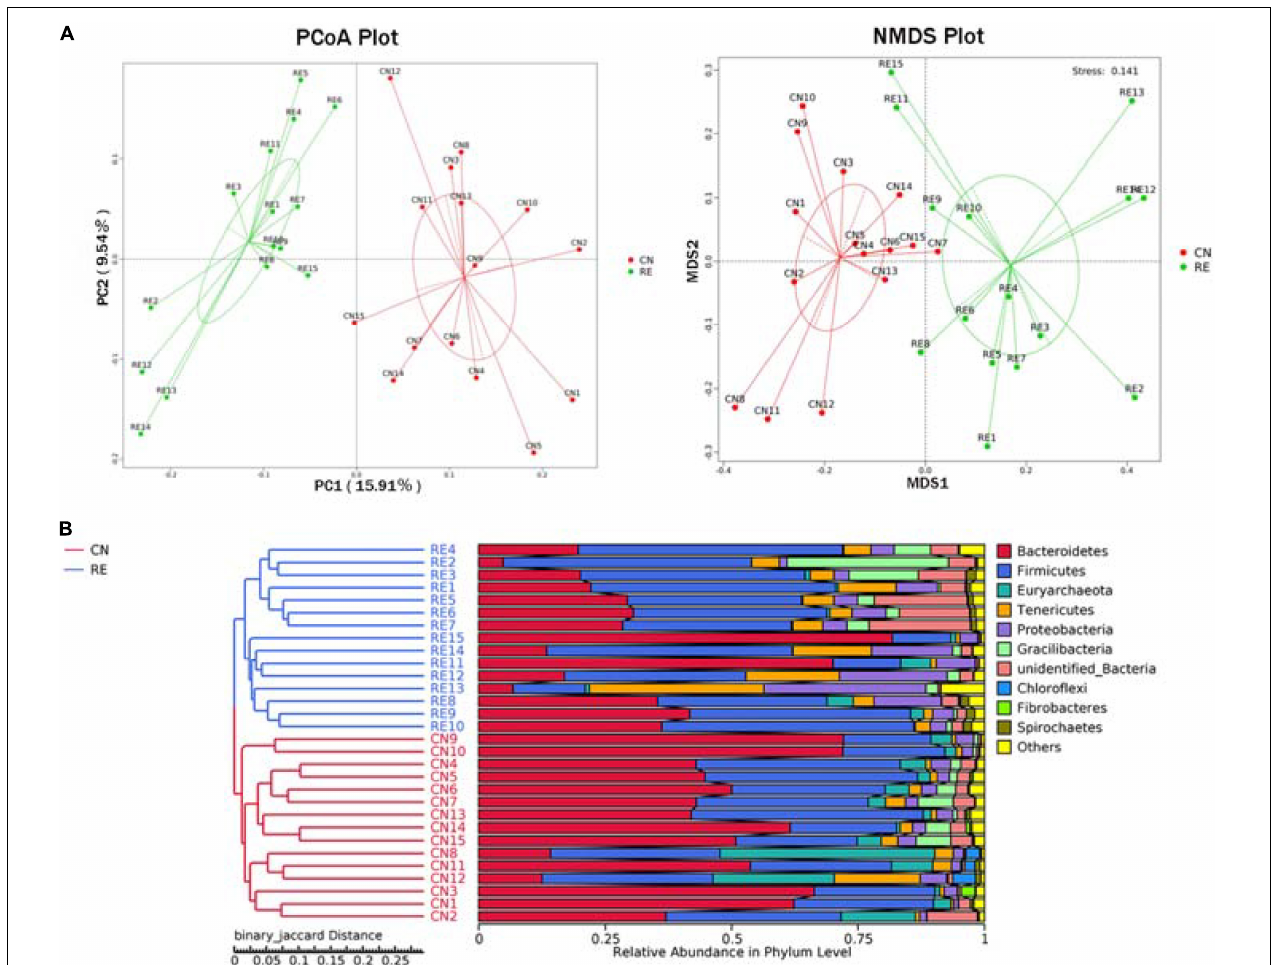
FIGURE 4 | (A) Principal coordinate analysis (PCoA) and non-metric multi-dimensional scaling (NMDS). (B) Unweighted pair group method with arithmetic means (UPGMA) cluster tree based on binary Jaccard distance. (A) The PCoA was based on the unweighted UniFrac distance, and the NMDS analysis was based on the Bray–Curtis distance. Each point in the figure represents a sample, and the samples in the same group are represented by the same color. (B) On the left is the UPGMA cluster tree structure of each sample at the OUT level, and on the right is the relative abundance distribution map of each sample at the phylum level. CN, no herbal tea residues; RE, 50% HTR replaced Pennisetum purpureum